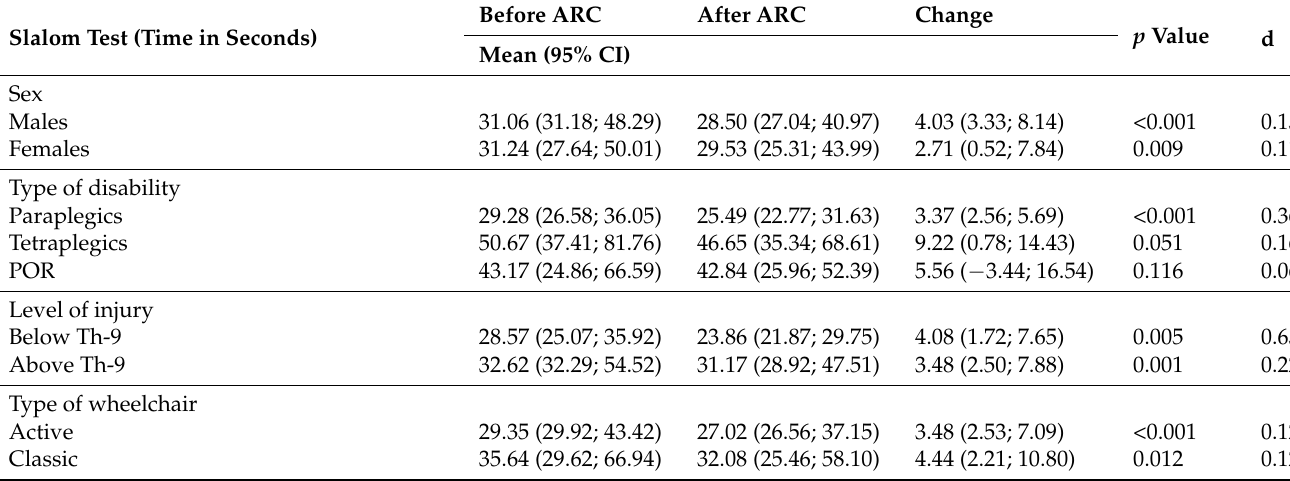
Table 3. The results obtained in the slalom test by the study participants before and after ARC.